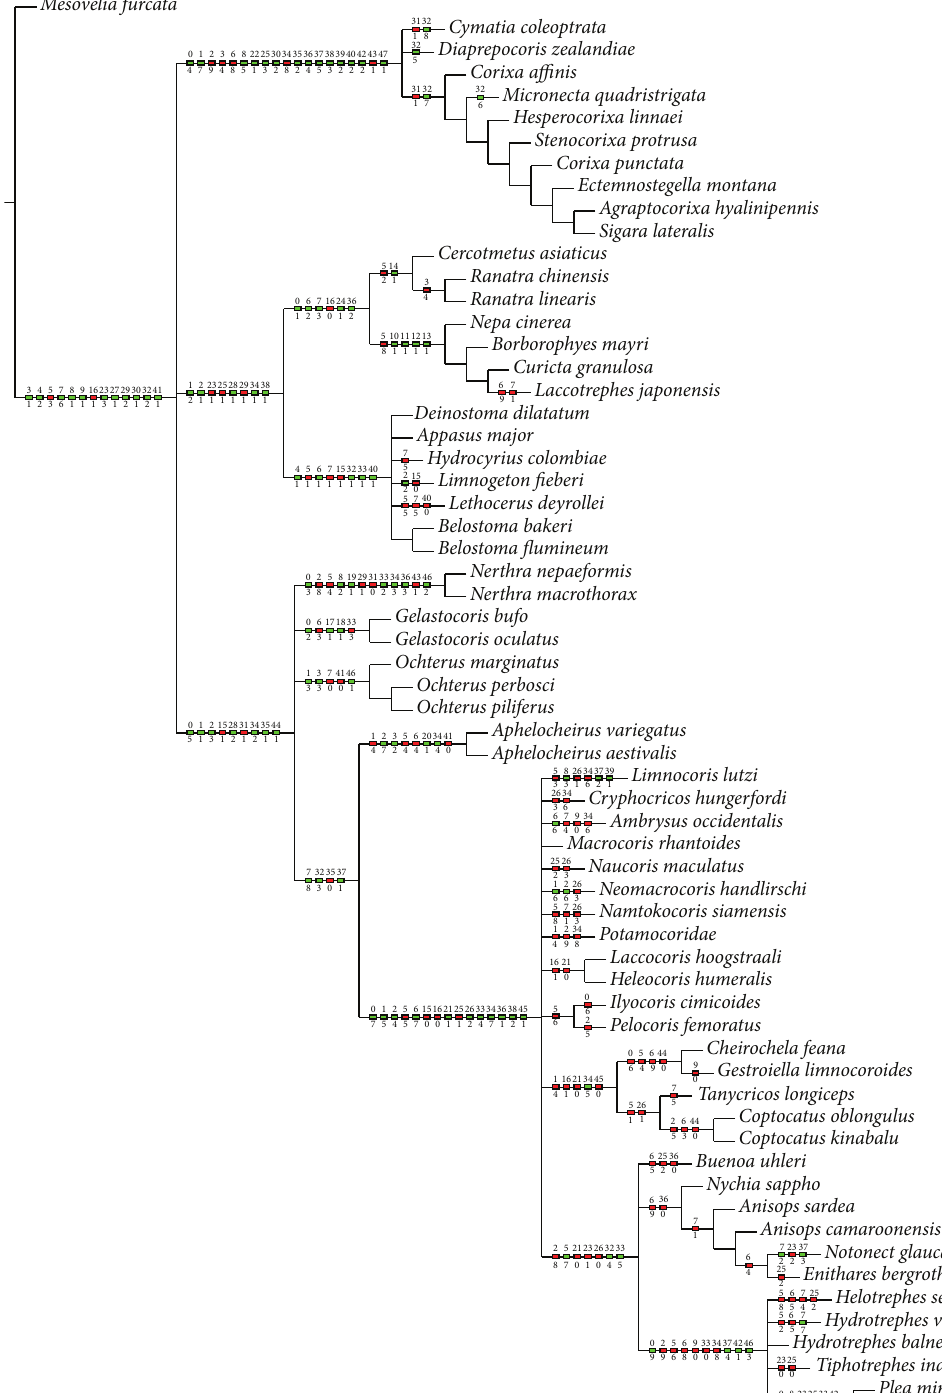
Figure 6: The strict consensus tree created from 100 parsimonious trees resulting from the heuristic search with characters treated as unordered and equally weighted (tree length = 221, consistency index = 63, retention index = 74). A green box indicates nonhomoplasy; a red box indicates homoplasy. The number above the branch line refers to the number of a character; the number below the line of the branch refers to number of the state of a character. The slow option is